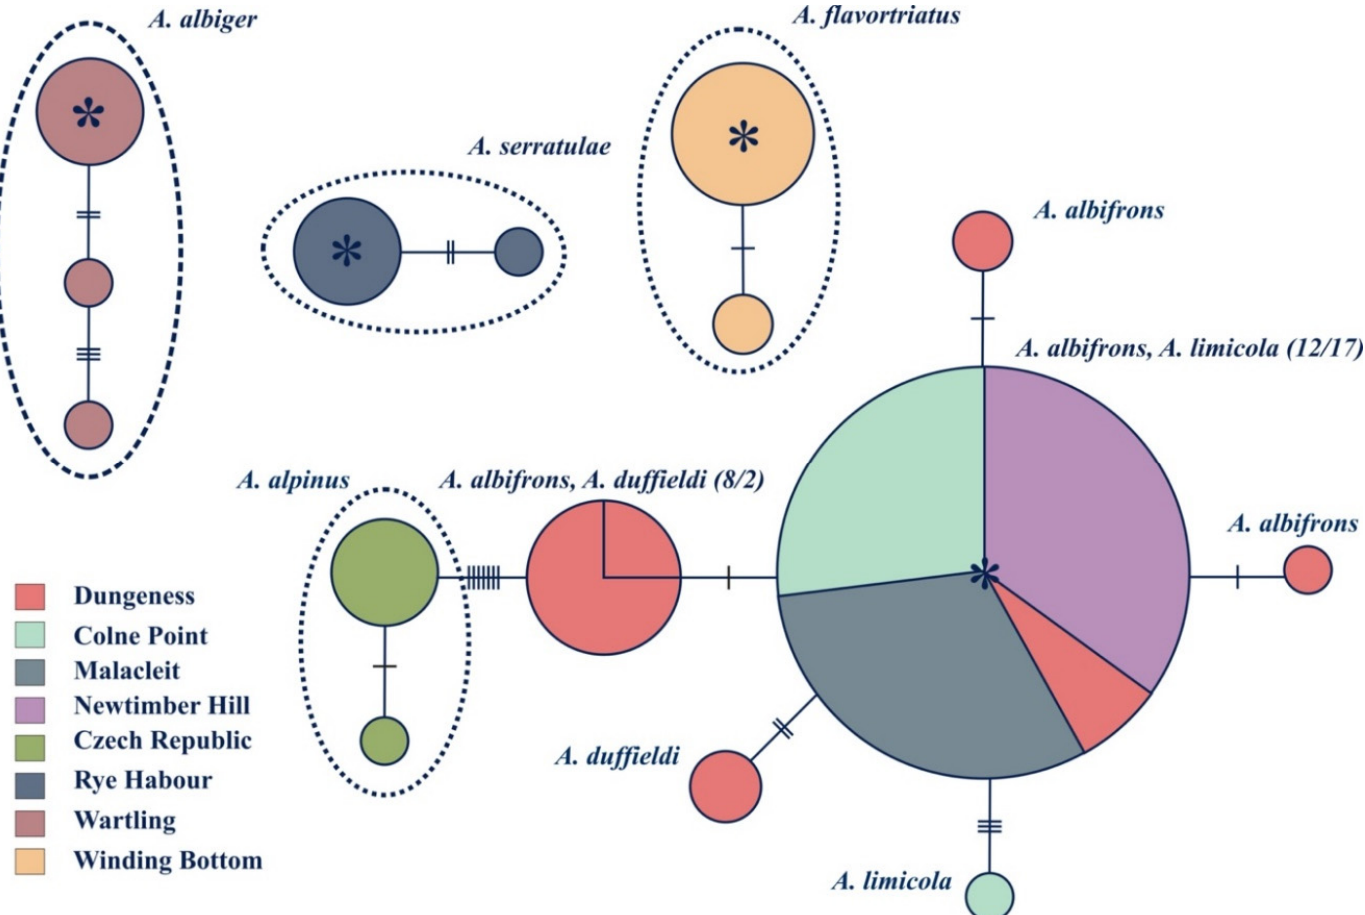
Figure 6. TCS network based on the mitochondrial 16S rRNA gene. Each circle represents a unique haplotype, and the size of each circle is proportional to the number of samples. Cross-hatching along branches represents the number of mutational steps. (TCS only connects alleles with a 95% confidence limit, i.e., 10 steps). The colours represent localities, and the circles are labelled with the name of the haplotype as seen in Figures 2–4. Stars indicate ancestral haplotypes.